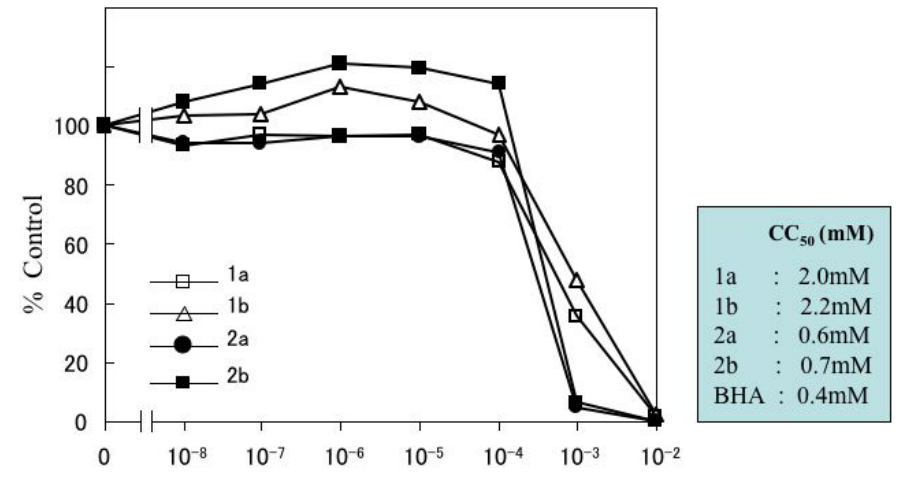
Figure 3. Cytotoxicity of p -cresol ( 1a ), p -cresol dimer ( 2a ), p -methoxyphenol ( 1b ), p - methoxyphenol dimer ( 2b ) and BHA towards RAW264.7